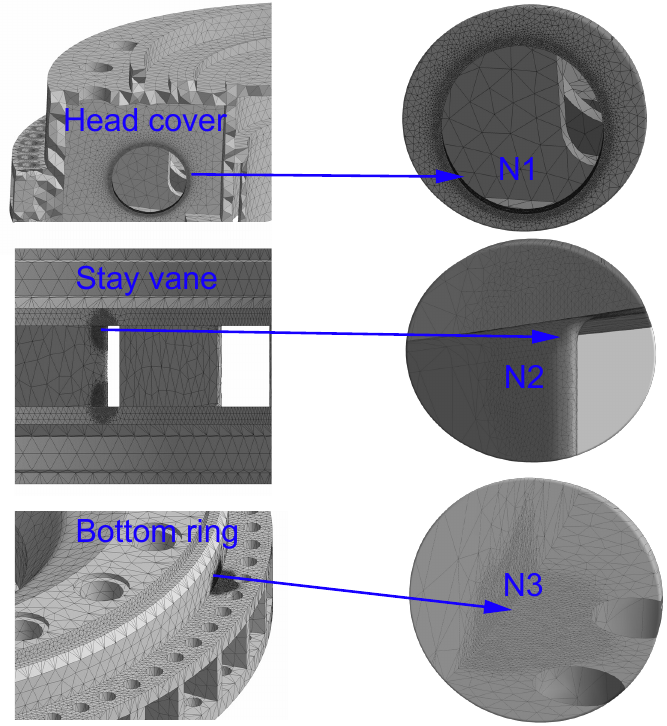
Figure 10. The meshes of the non-rotating structures of the pump-turbine unit.